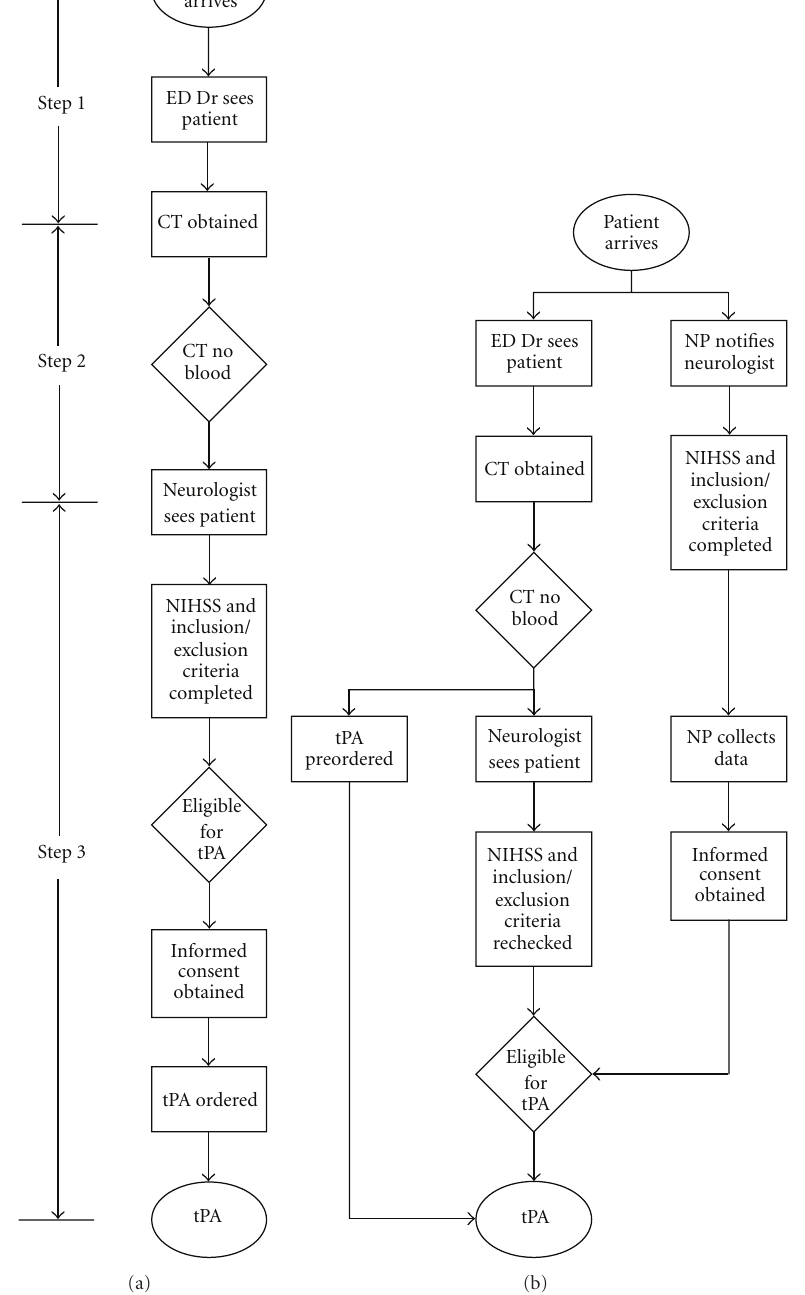
Figure 1: The original thrombolysis protocol based on a sequential algorithm (a) and the new thrombolysis protocol based on a parallel algorithm